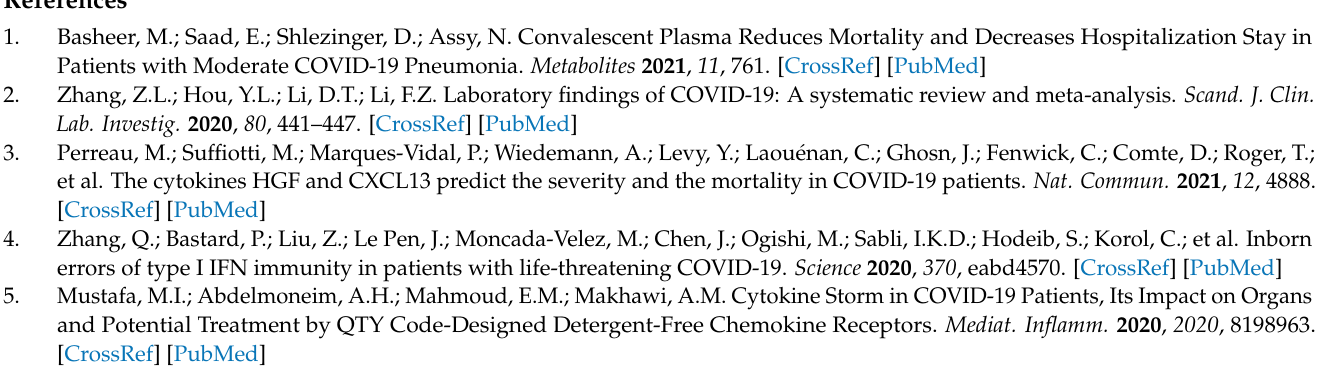
Table S3: Characteristics of the control group, Figure S1: TNF- α concentrations range according to each study group, Figure S2: TNF- α concentrations range according to each study group, without extreme outliners for a better visibility, Figure S3: IFN- β concentrations range according to each study group, Figure S4: IFN- β concentrations range according to each study group, without extreme outliners for a better visibility, Figure S5: IFN- γ concentrations range according to each study group, Figure S6: IL-1 β concentrations range according to each study group, Figure S7: IL-1 β concentrations range according to each study group, without extreme outliners for a better visibility, Figure S8: IL-2 concentrations range according to each study group, Figure S9: IL-2 concentrations range according to each study group, without extreme outliners for a better visibility, Figure S10: IL-5 concentrations range according to each study group, Figure S11: IL-5 concentrations range according to each study group, without extreme outliners for a better visibility, Figure S12: IL-6 concentrations range according to each study group, Figure S13: IL-6 concentrations range according to each study group, without extreme outliners for a better visibility, Figure S14: IL-10 concentrations range according to each study group, Figure S15: IL-10 concentrations range according to each study group, without extreme outliners for a better visibility, Figure S16: GM-CSF concentrations range according to each study group, Figure S17: GM-CSF concentrations range according to each study group, without extreme outliners for a better visibility, Figure S18: IP-10 concentrations range according to each study group, Figure S19: ROC curves generated for biomarkers that best predicted the infection status: TNF-alpha and